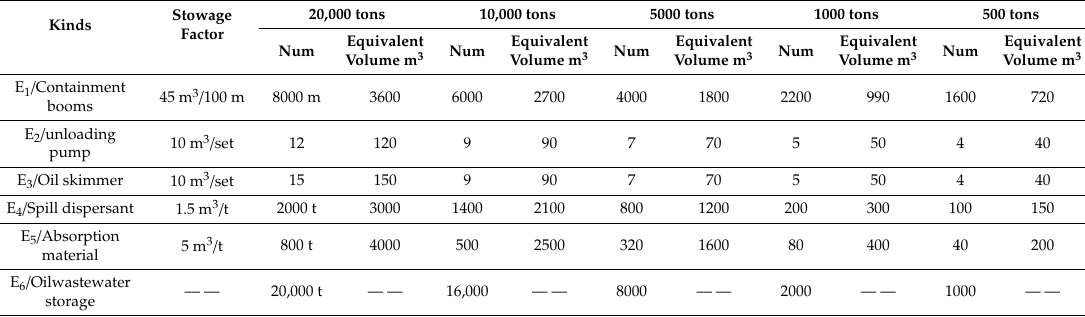
Table 1. Estimationof emergency materials required for accidents with di ff erent o ff shore oil spill